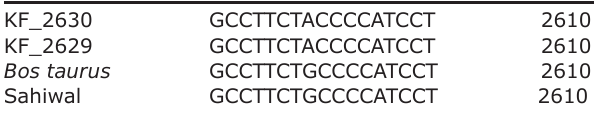
Table-3: Comparative nucleotide sequences of Karan Fries (KF), Bos taurus and Sahiwal cattle showing nucleotide change at position 2601 (G>A).